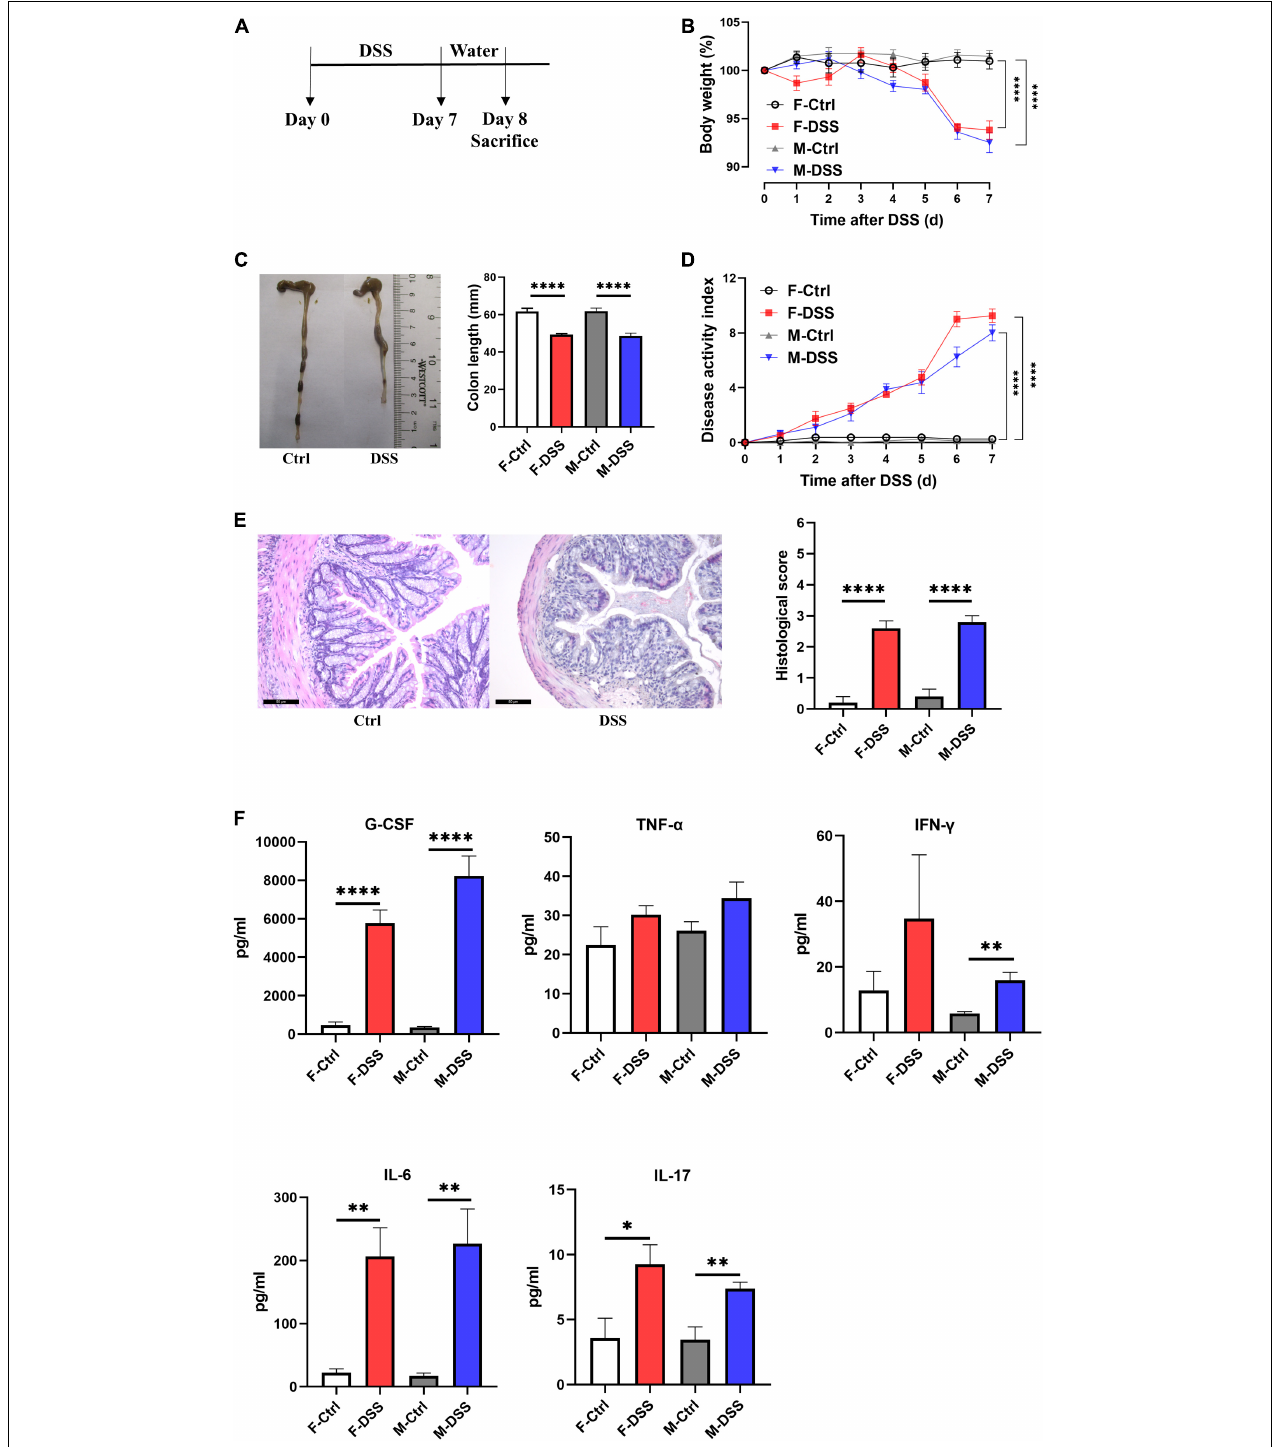
FIGURE 1 | Both female and male mice with acute DSS-induced colitis displayed significant inflammation in the colon and systemic inflammation. (A) Experimental scheme illustrating DSS treatment protocol for acute models. Changes in (B) body weight and (D) disease activity index (DAI) during DSS treatment. (C) Colon length and representative photographs for colon tissue in DSS-treated and control mice. (E) Representative images of H&E staining of colon tissue ( × 200; scale bar, 50 µ m), and summary of histological score. (F) Levels of plasma cytokines in male and female mice with acute colitis model. Data are expressed as mean ± SEM. ∗ p < 0.05, ∗∗ p < 0.01, ∗∗∗∗ p < 0.0001, in unpaired 2-tailed Student’s t -test (B–F) , n = 5–8 mice each group. F and M, female and male mice, respectively. G-CSF, granulocyte colony-stimulating factor; TNF- α , tumor necrosis factor alpha; IFN- γ , interferon gamma; IL, interleukin.